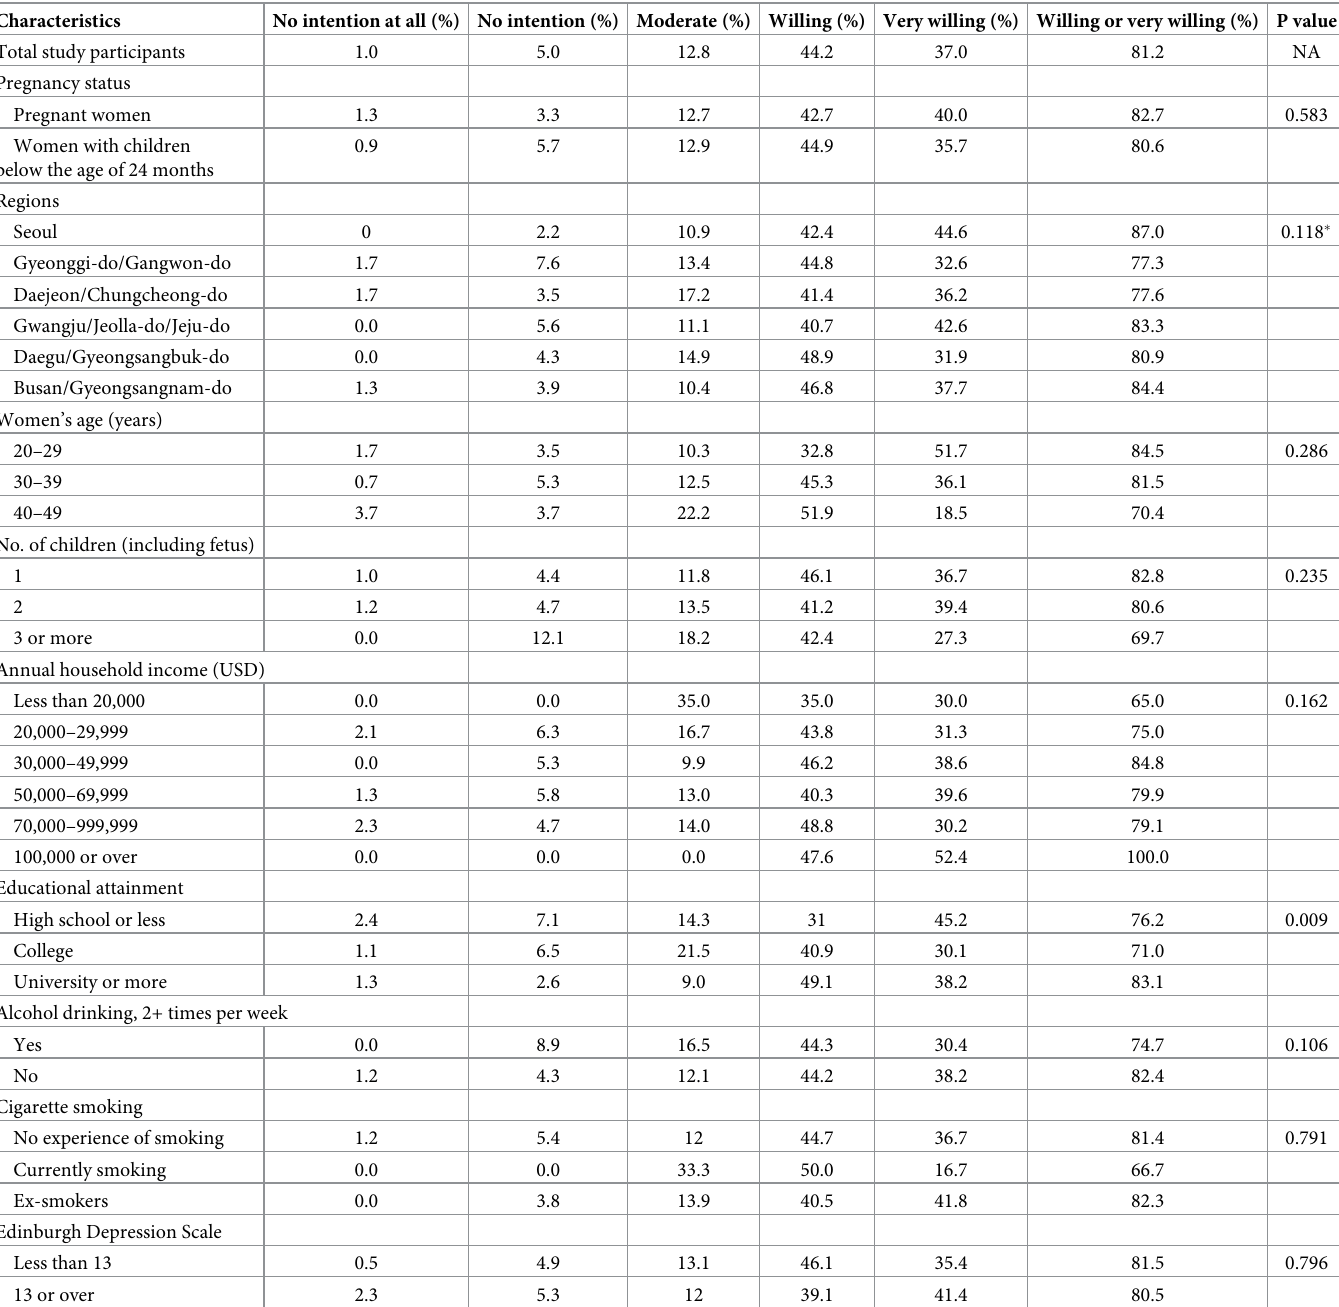
Table 3. Intention to use nurse home visitation services (%) among pregnant women and mothers with children below the age of 24 months (N = 500).